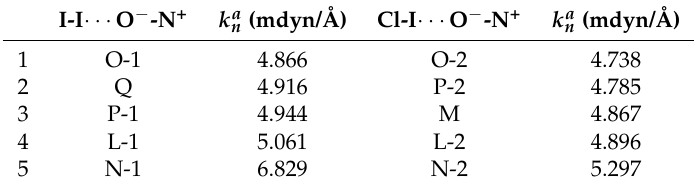
Table 3. Local stretching force constants of the N + -O − bonds within acceptor molecules L–Q in ascending